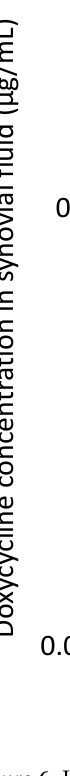
Figure 6. Individual concentration of doxycycline in synovial fluid vs. time during intragastric administration of doxycycline at 10 mg/kg q12 h from 0 to 48 h in 8 healthy jennies. Each solid triangle represents the value from one jenny at each time point.